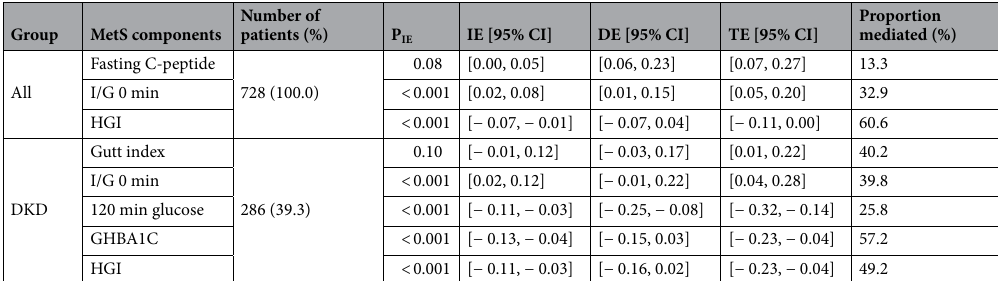
Table 5. DE, IE, and TE of MetS components on renal function impairment (UMALB) mediated through serum Mb (Significant). TE total effect, DE direct effects, IE indirect effects, CI confidence interval.